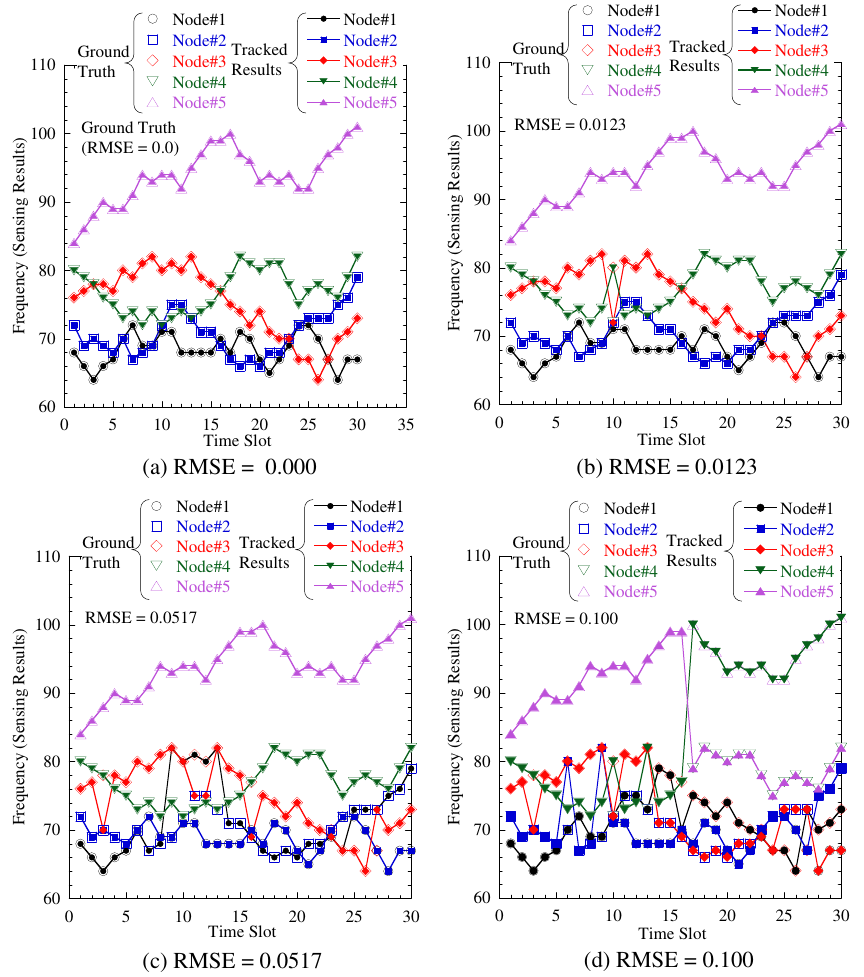
Figure 6. Snap shot of separation result under various RMSE.